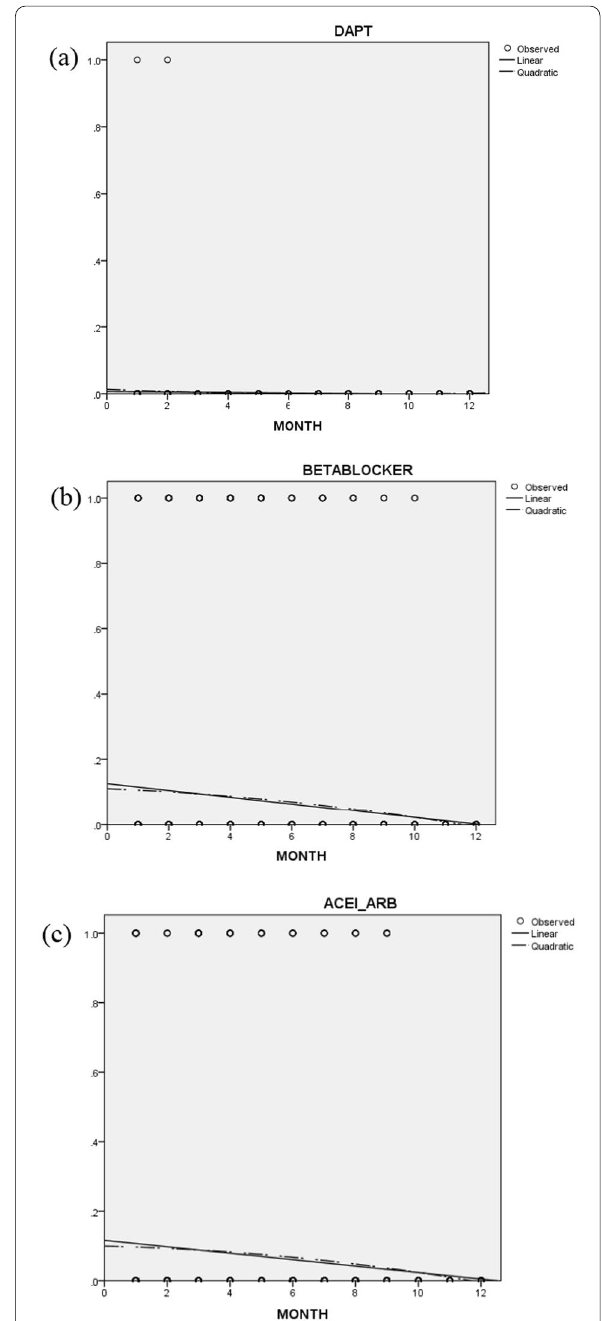
Fig. 2 a Curve estimation analysis of usage of DAPT (dual antiplatelets) (linear and quadratic). b Curve estimation analysis of usage of BB beta-blockers. c Curve estimation analysis of usage of ACEI angiotensin-converting enzyme inhibitor, ARB angiotensin receptor